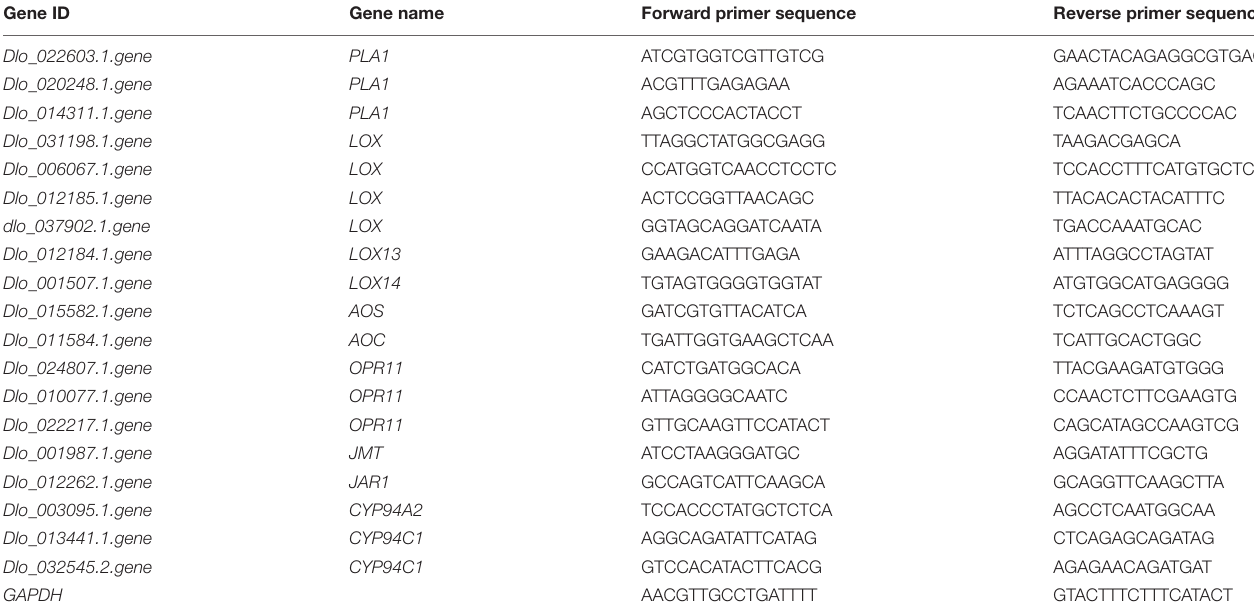
TABLE 2 | List of primers used for real-time quantitative polymerase chain reaction (RT-qPCR) analyses of the selected